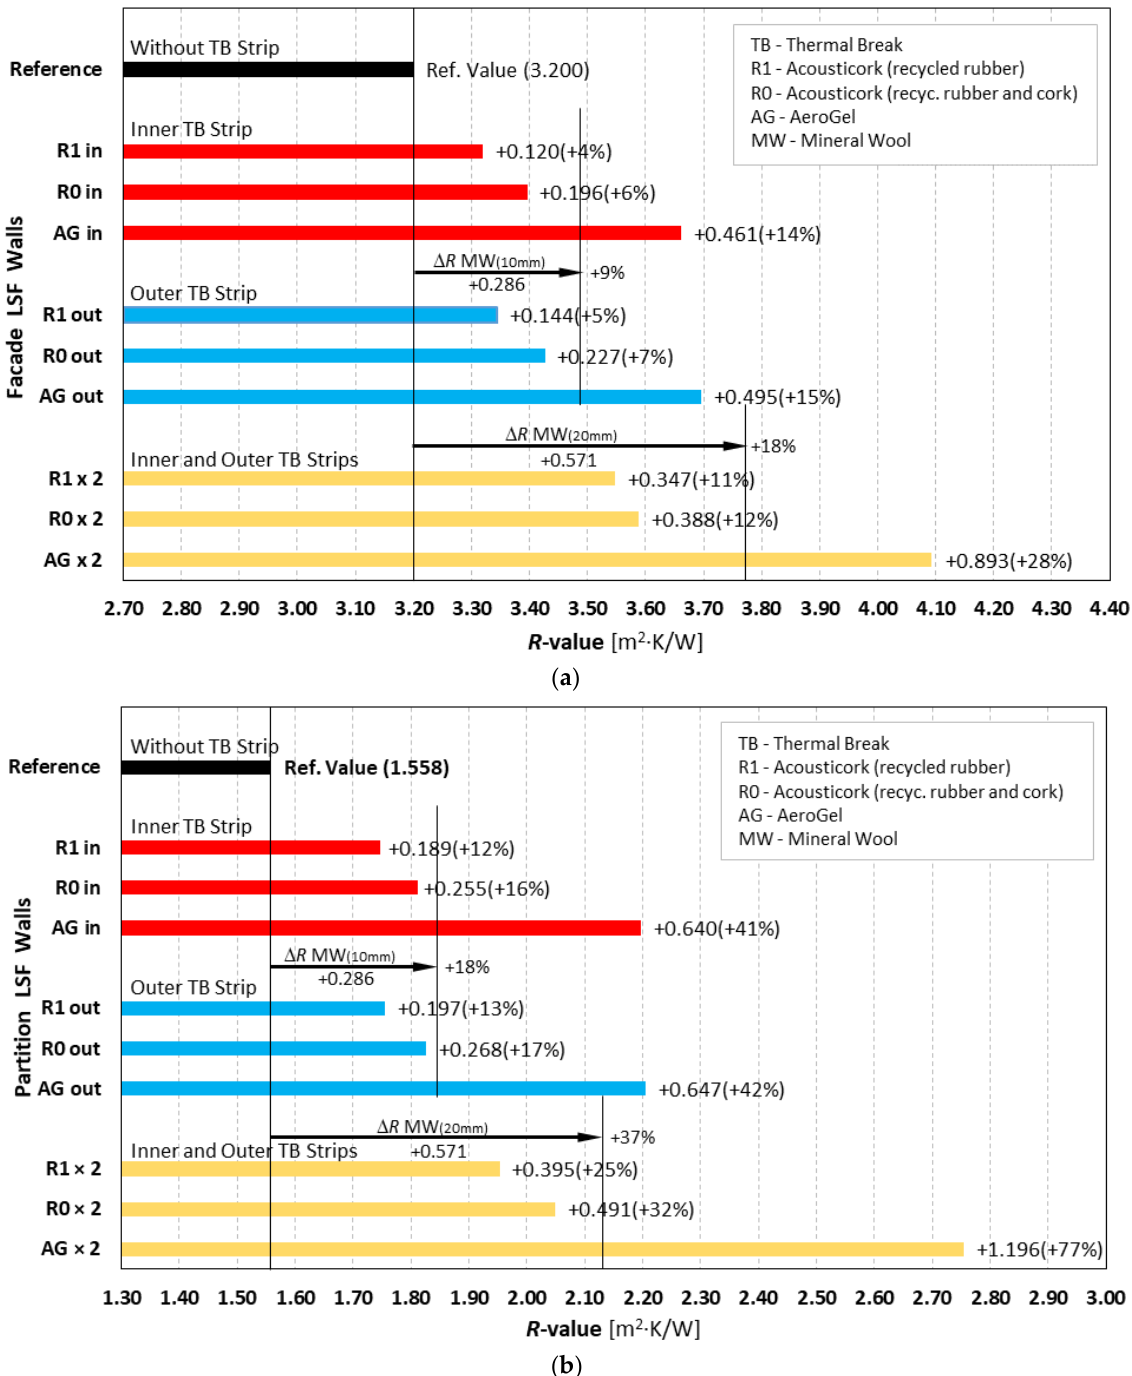
Figure 8. Measured thermal resistances of load-bearing LSF walls. ( a ) Facade LSF walls. ( b ) Partition LSF walls (adapted from [30]).